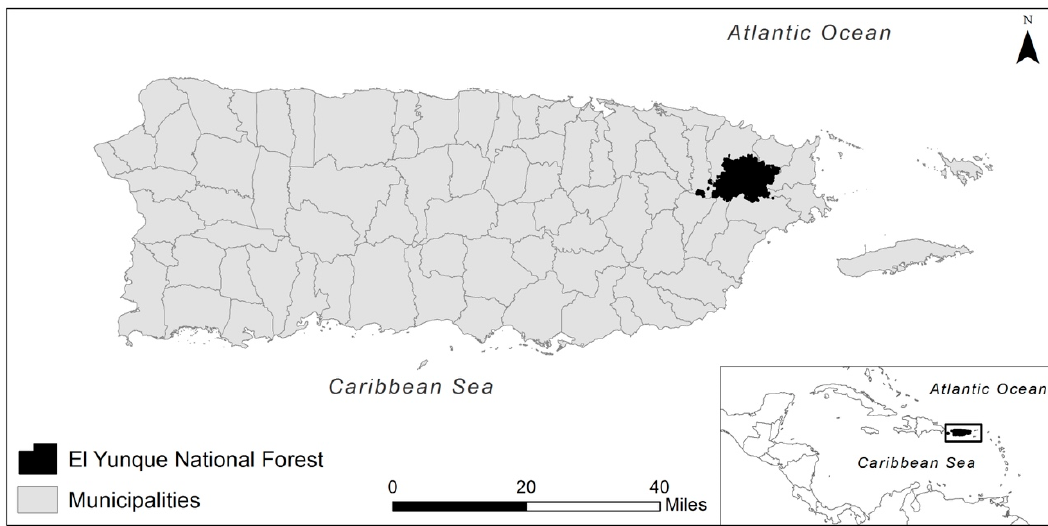
Figure 1. Map of Puerto Rico and the location of the Luquillo Experimental Forest. 51